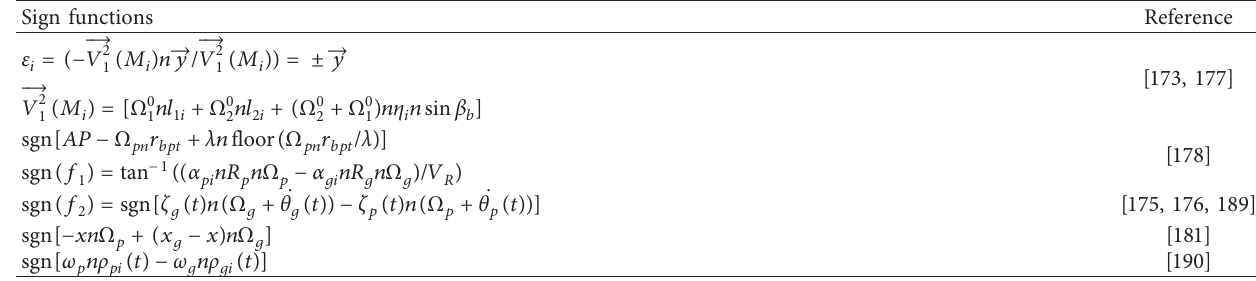
Table 2: Sign functions for frictional excitations.